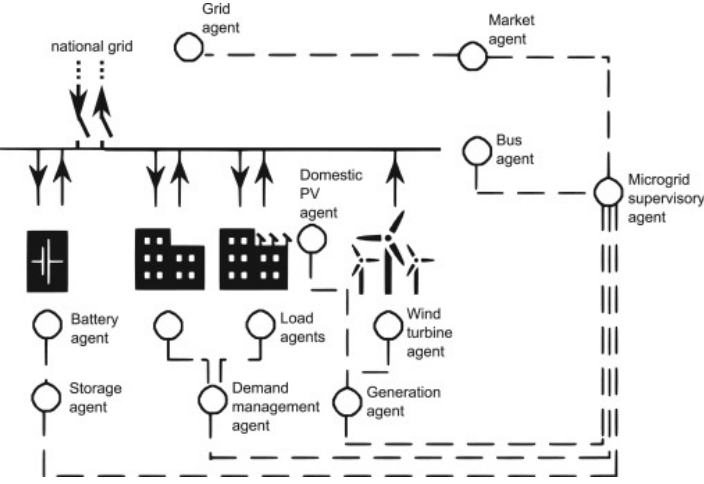
Fig. 3 Structural diagram of the integrated management system for energy saving and consumption reduction of a distribution network based on